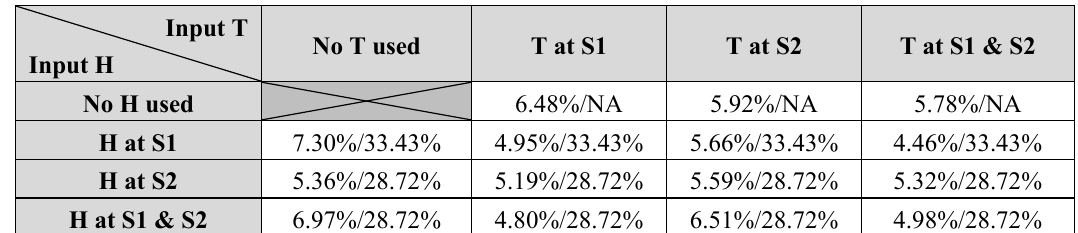
Table 2. Data Estimation results (% error ANN/% error interpolation) for Humidity (H) in Sensor 3 (S3), combining Temperature (T) and Humidity in Sensors 1 and 2 (S1 and S2) as